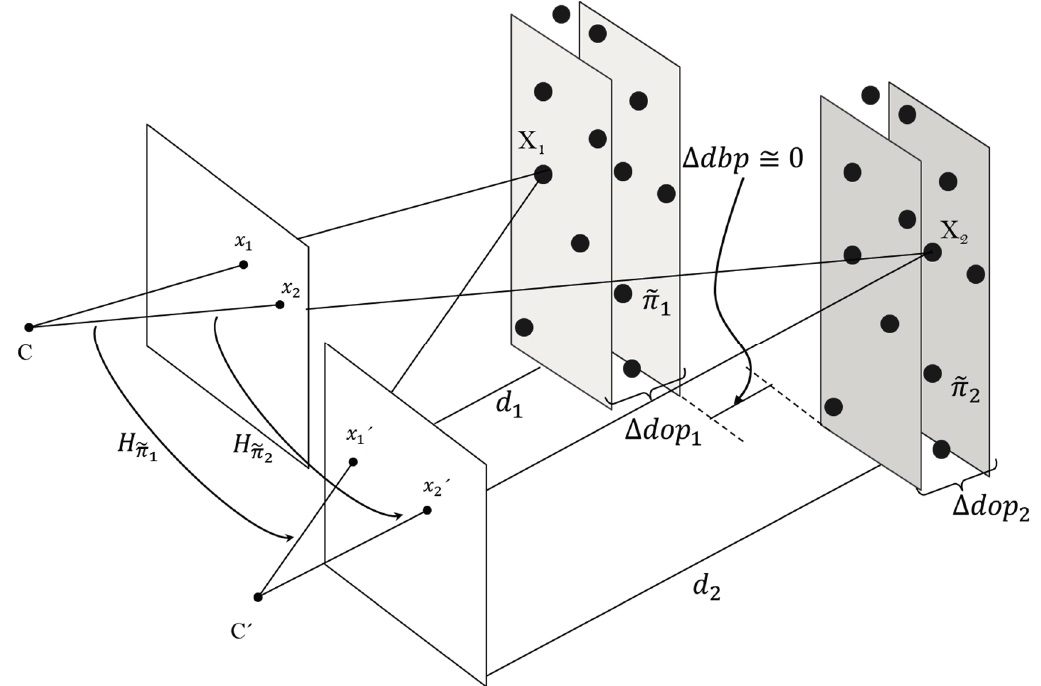
Figure 4. Formation of the depth-dependent homography lookup